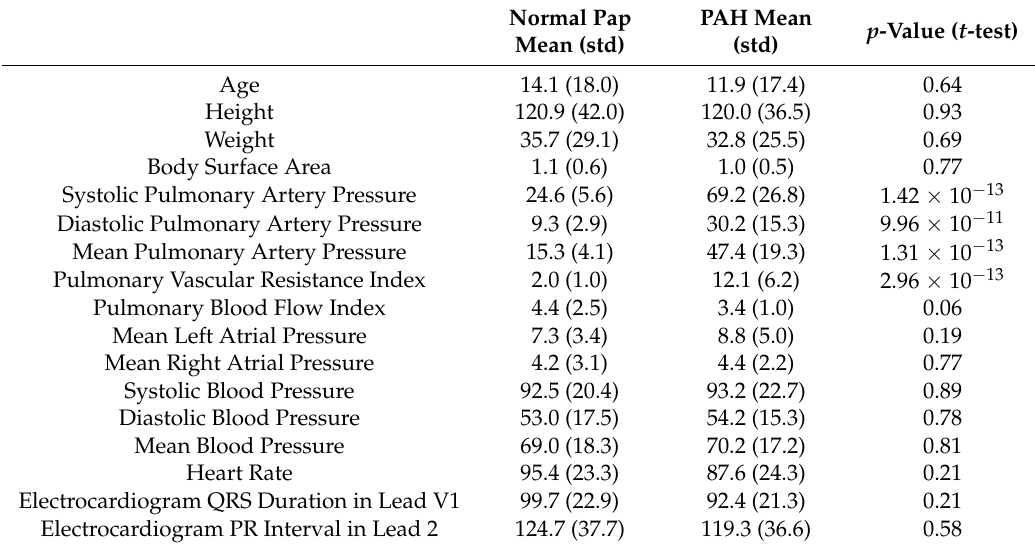
Table 1. Comparison of clinical and hemodynamic data between subjects with pulmonary artery hypertension (mean PAp ≥ 25 mmHg) and subjects with normal pulmonary artery pressures (mean PAp < 25